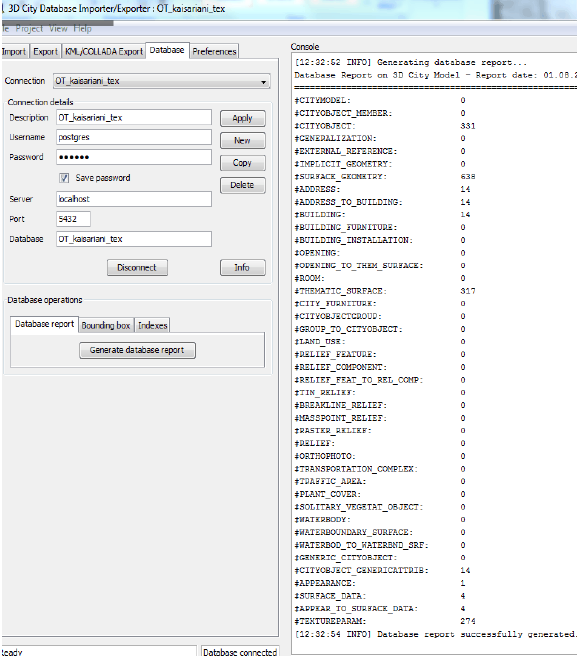
Figure 6. Environment of 3DCityDB-Importer-Exporter